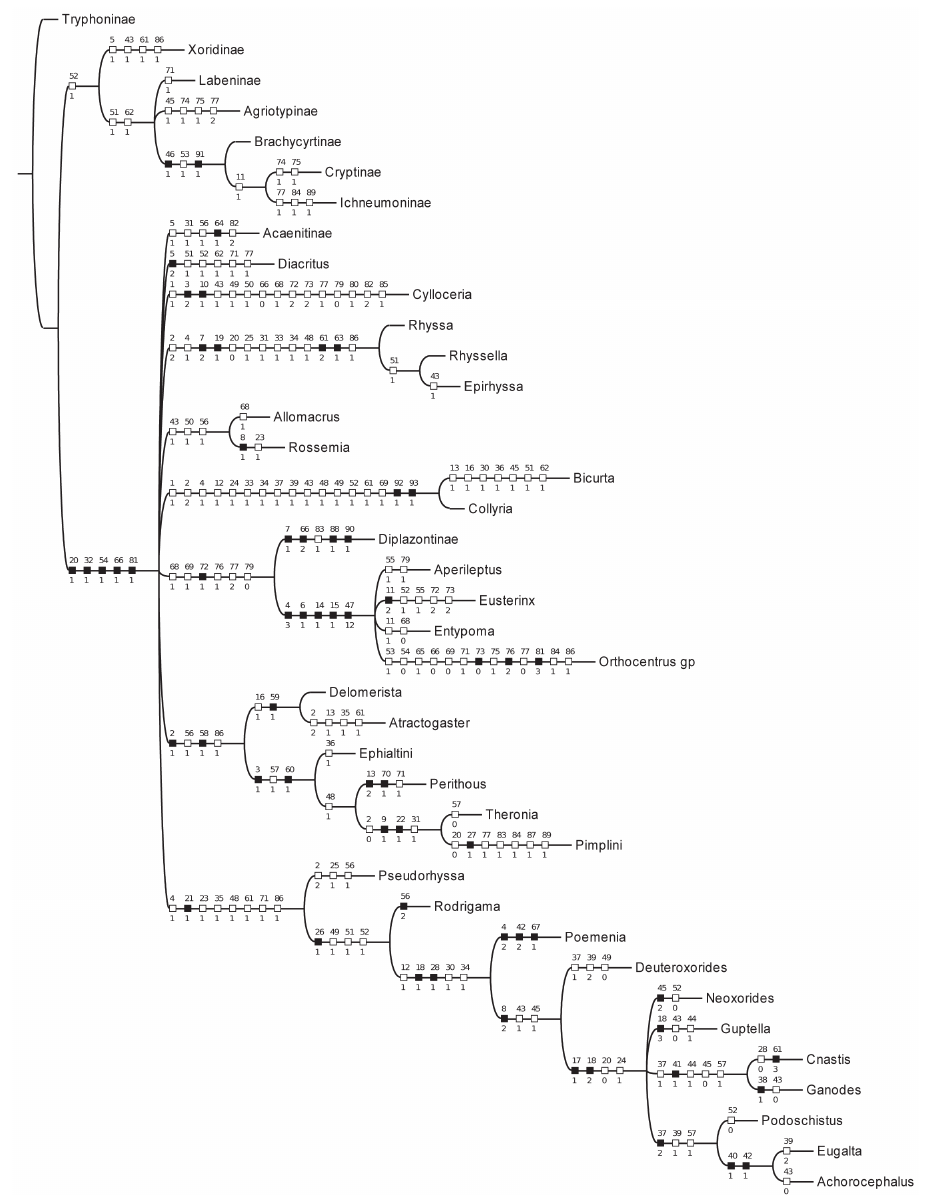
Figure 1. Cladogram of selected pimpliformes taxa. Strict consensus of 12 trees of length 240. Apomor- phic characters are indicated by black squares, homoplasies by white squares. by Kuslitzky and Kasparyan 2011); antennae short; clypeus with median tubercle; posterior transverse carina of propodeum absent; hind coxa elongate; fore and mid claws with teeth; fore wing vein 3 rs-m absent; hind wing vein Cu 1 much closer to